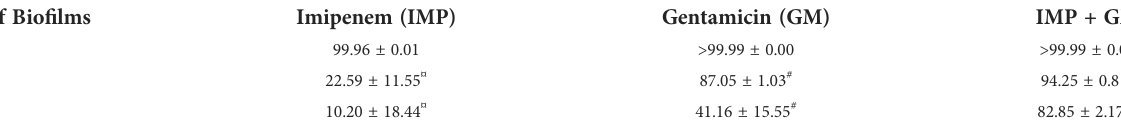
TABLE 1 Ef fi cacies of antibiotics on bactericidal rate (%) at different ages of P. aeruginosa bio fi lms (64× MIC, 4-h treatments in vitro , mean ± SE). Ages of Bio fi lms